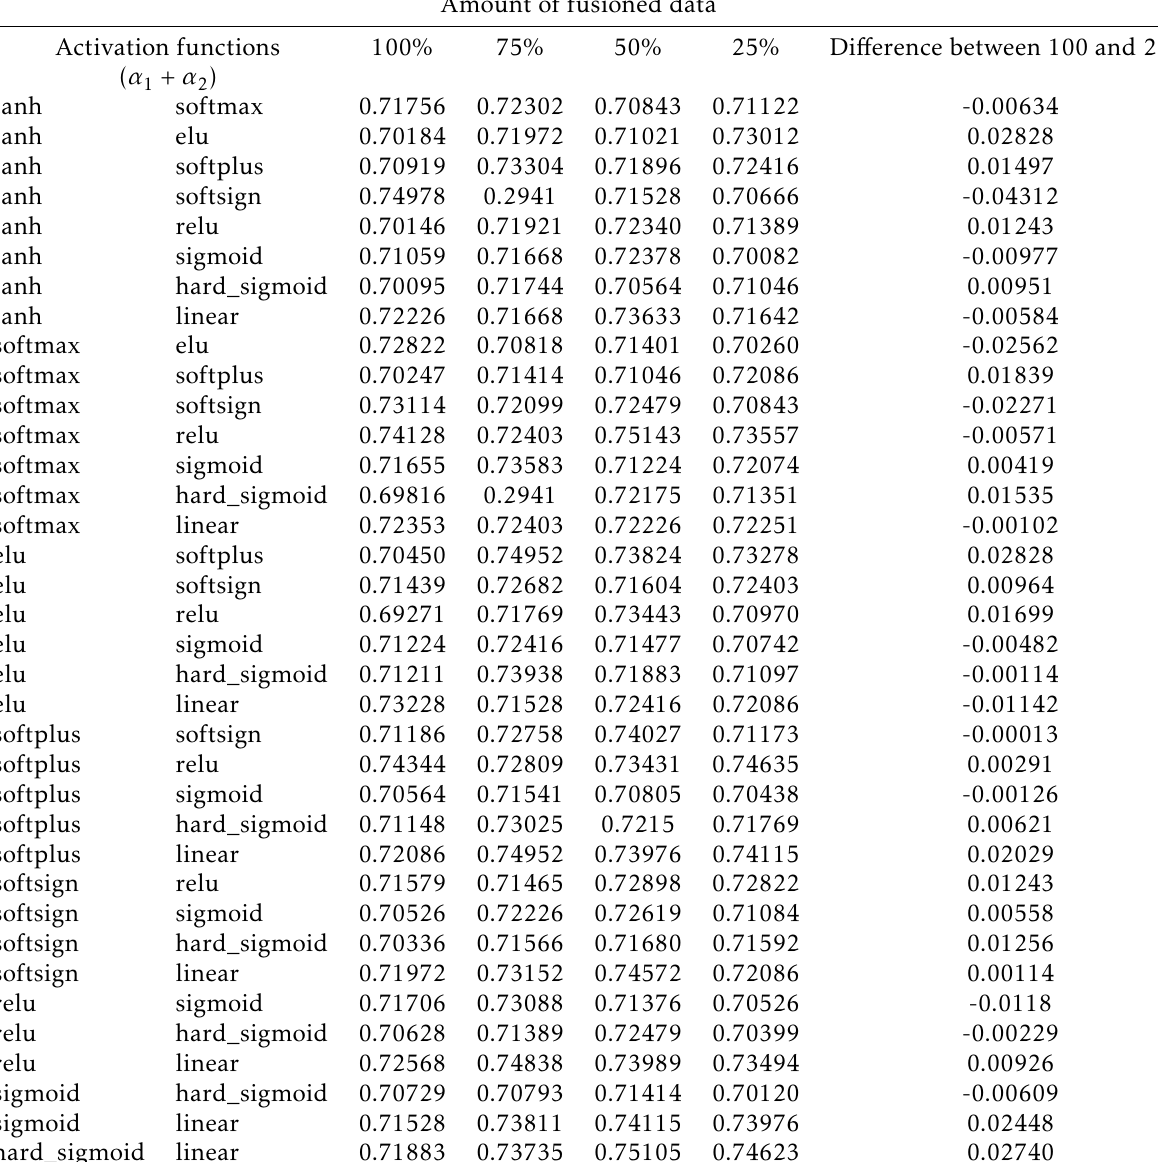
Table 1. Full results of the tuples for the activity recognition models for Subject 1. Complementary information of Table